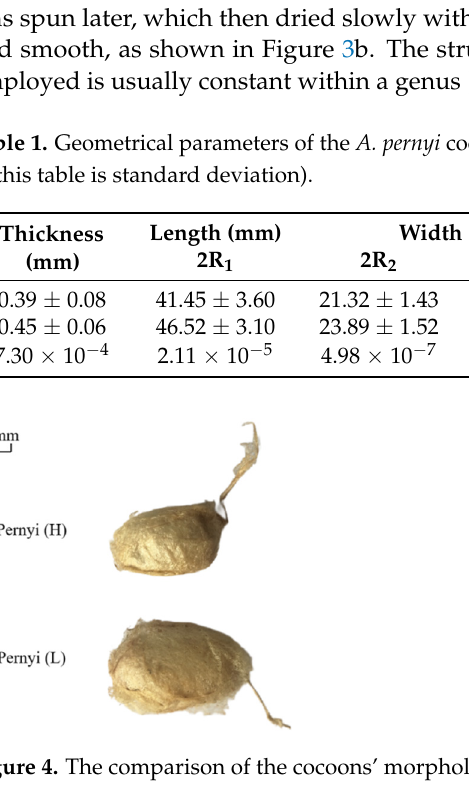
Figure 3. Digital images of the A. pernyi cocoons ( a ) vertical section; ( b ) cross section.